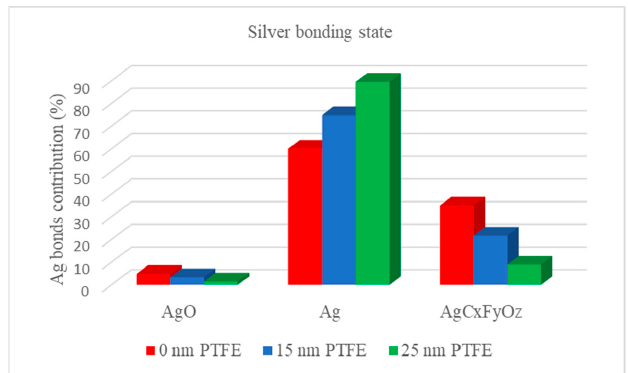
Figure 6. The evolution of Ag- related bonds as function of the PTFE barrier layer.